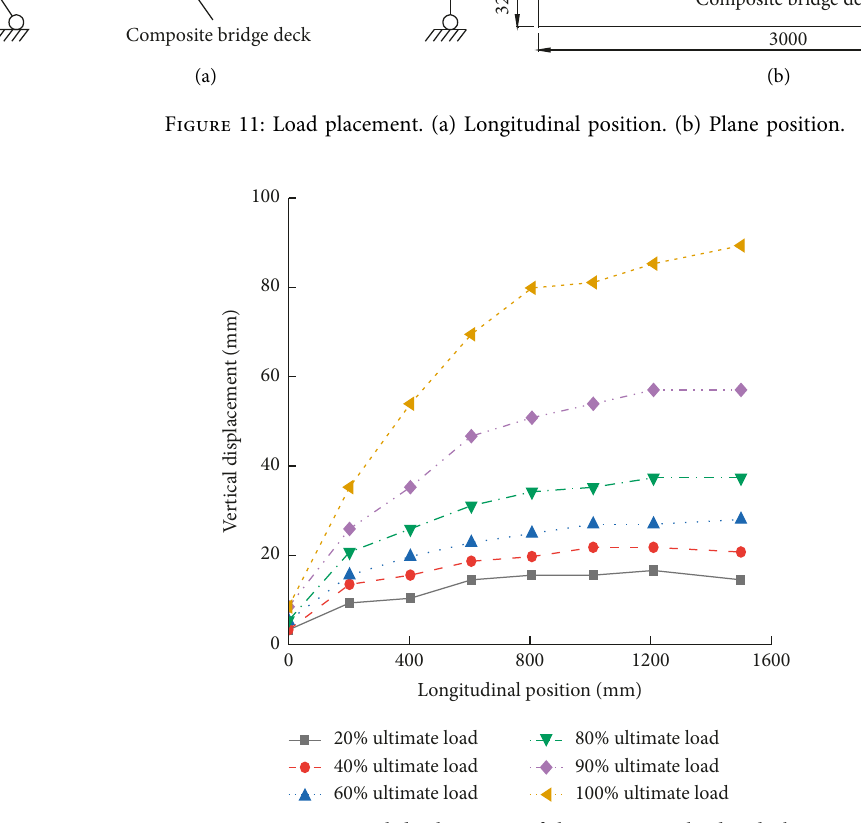
Figure 12: Vertical displacement of the composite bridge deck.